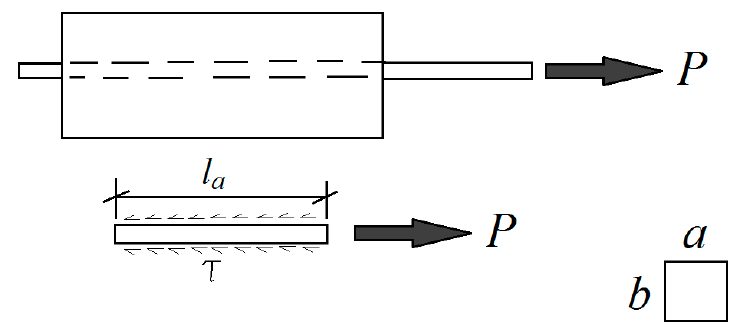
Figure 8. Equilibrium of forces in bond strength evaluation of bamboo composite bar and concrete during the pull-out test [32].